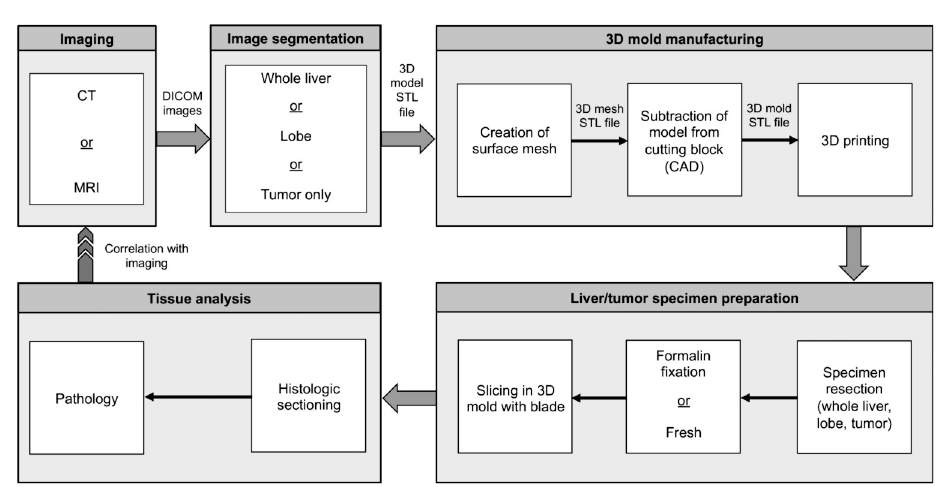
Fig 1. Schematic of procedural workflow. Correlating in vivo imaging with histopathology using liver- or tumor- specific 3D cutting molds.